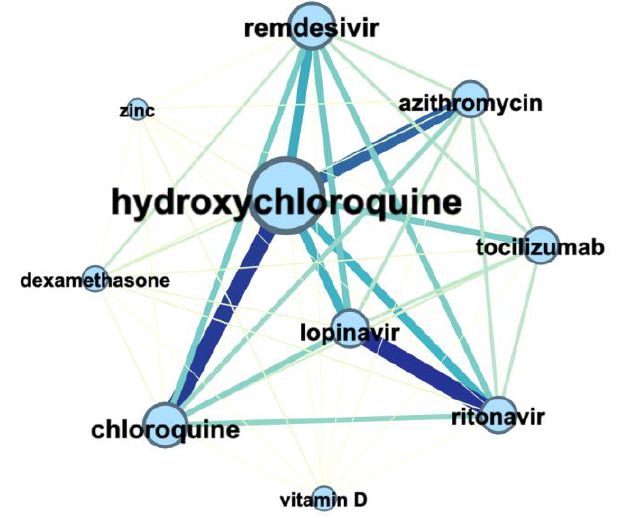
Figure 8. The connection between the medicines (UMLS Semantic Types: “pharmacological sub- stances” and “biological substances”) in COVID-19 articles from 1 January 2019 till 1 February 2020. The node and font size correspond to the number of entities’ mentions; the color and thickness of the edge corresponds to the number of connections between entities.